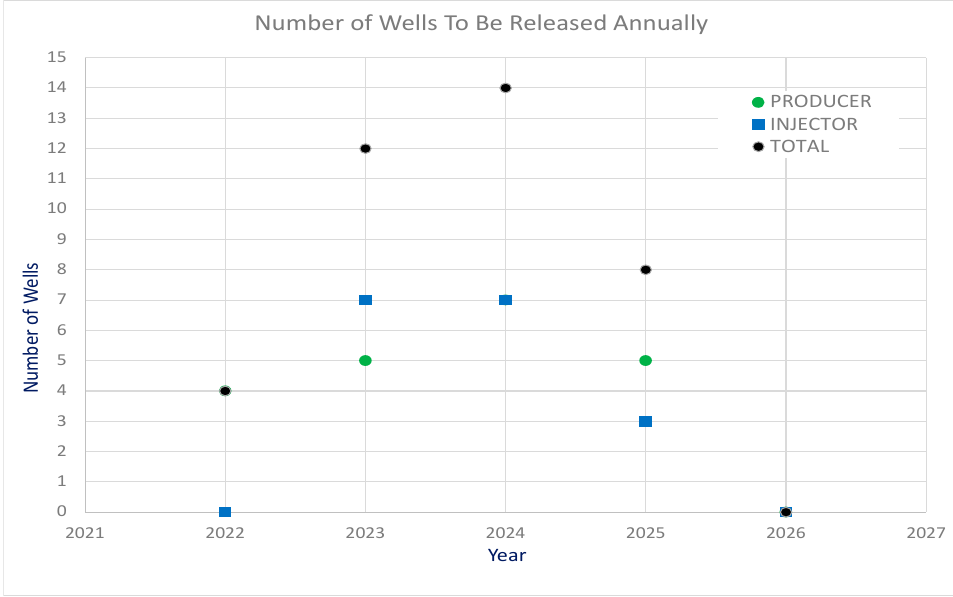
Figure 7. Number of wells to be released annually.